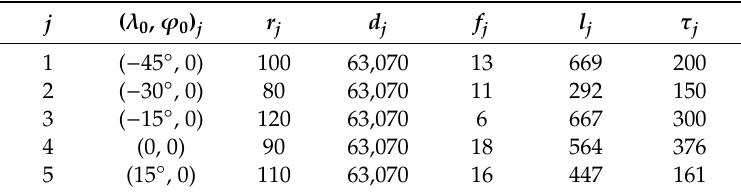
Table 2. Sun parameters. Table 5. ATWOs and